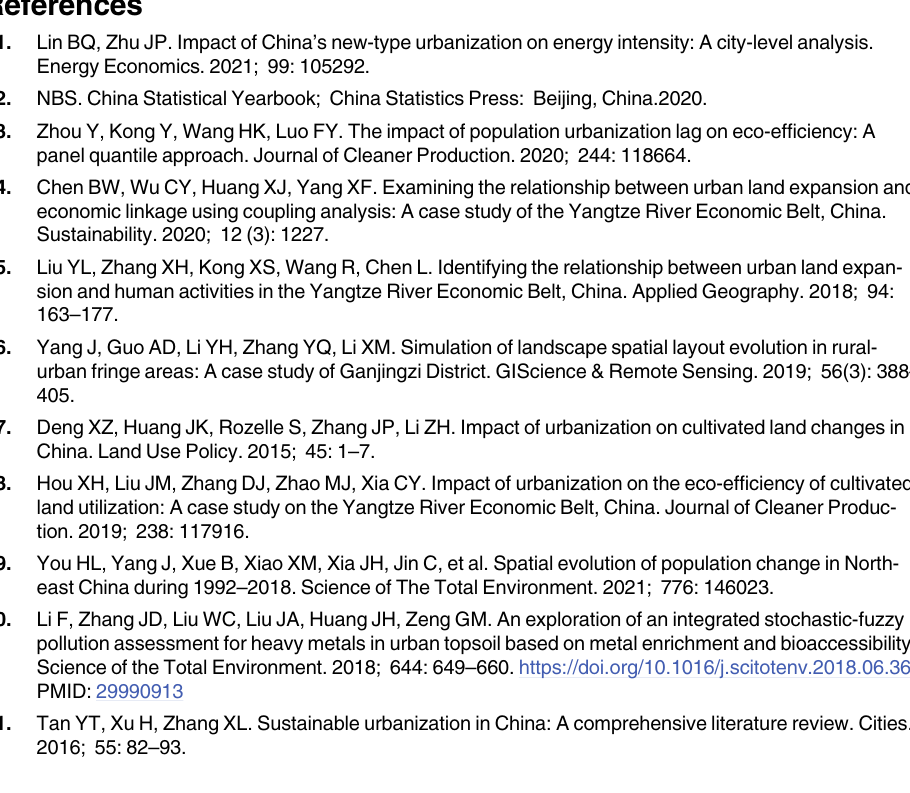
S3 Table. Data for level consistency evaluation of the population-land urbanization in the YEB in 2007, 2010, 2013, 2017-spreadsheet. S4 Table. Data for space matching evaluation of the population-land urbanization in the YEB in 2007, 2010, 2013,